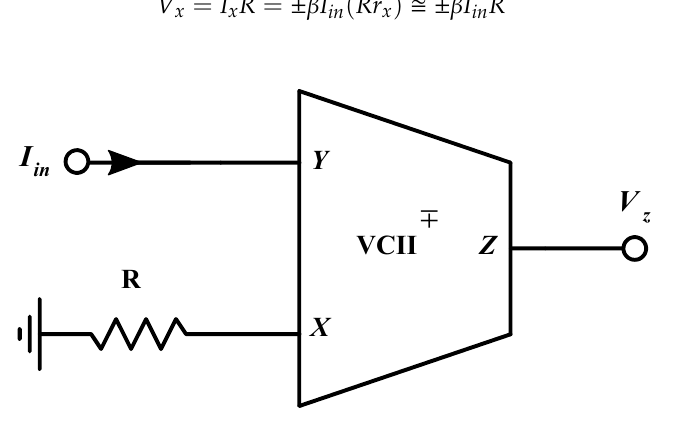
Figure 2. VCII configuration as current to voltage converter.